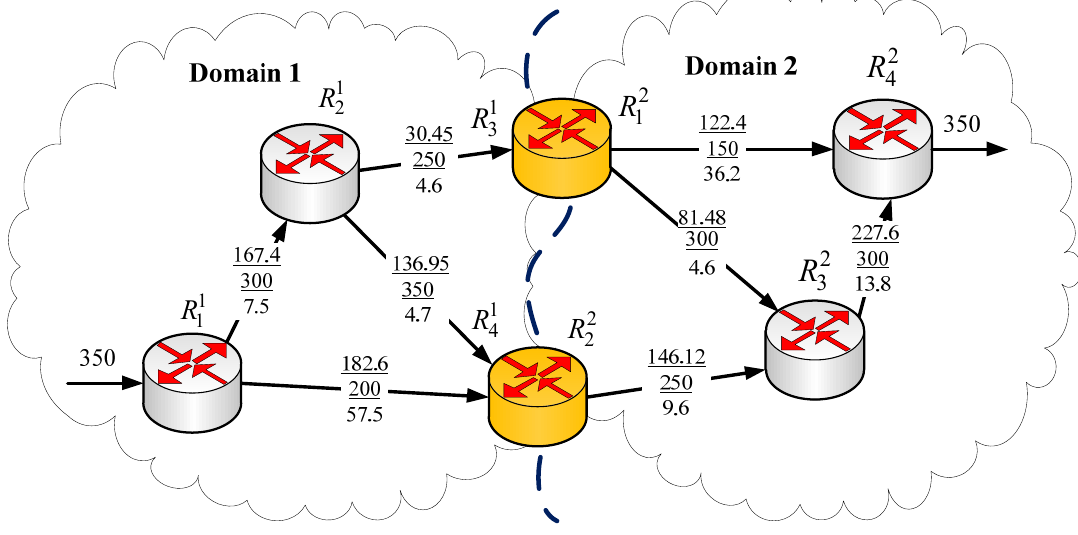
Figure 8. Initial solution to the inter-domain QoS routing problem following the normalized requirements (24).